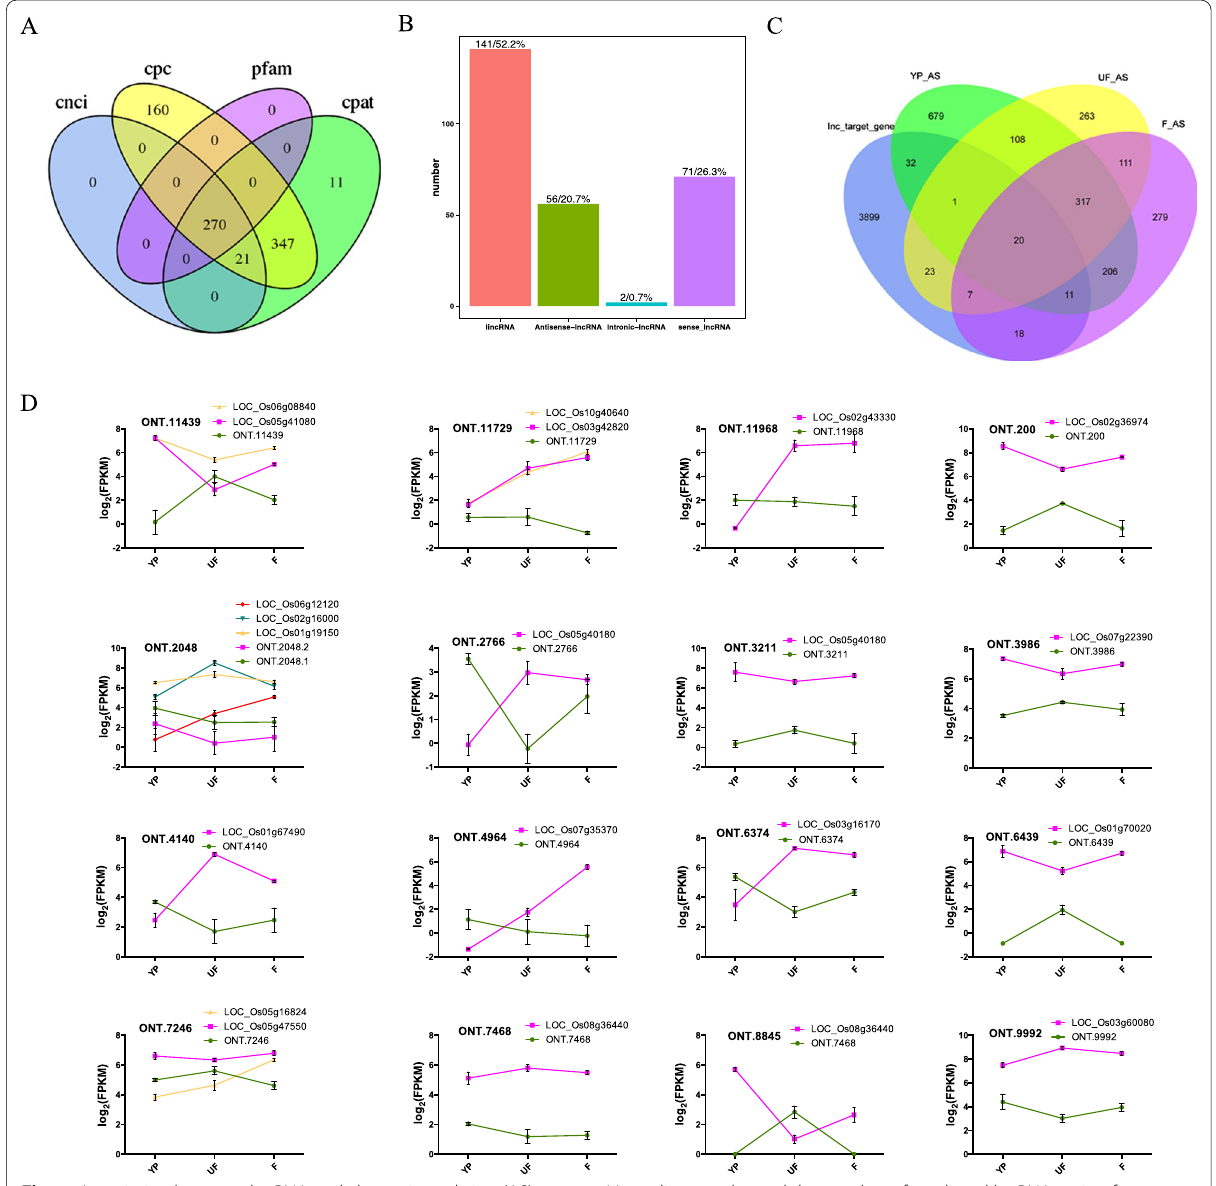
Fig. 5 Association between lncRNA and alternative splicing (AS) genes. a Venn diagram showed the number of predicted lncRNAs using four methods. b Percentage of the four lncRNA types among the total predicted lncRNAs. c Comparison of the lncRNA predicted genes with AS corresponding genes in three developmental stages. d Examples of the expression pattern of lncRNA-AS interactions. Error bar represents mean SD with three biological ±